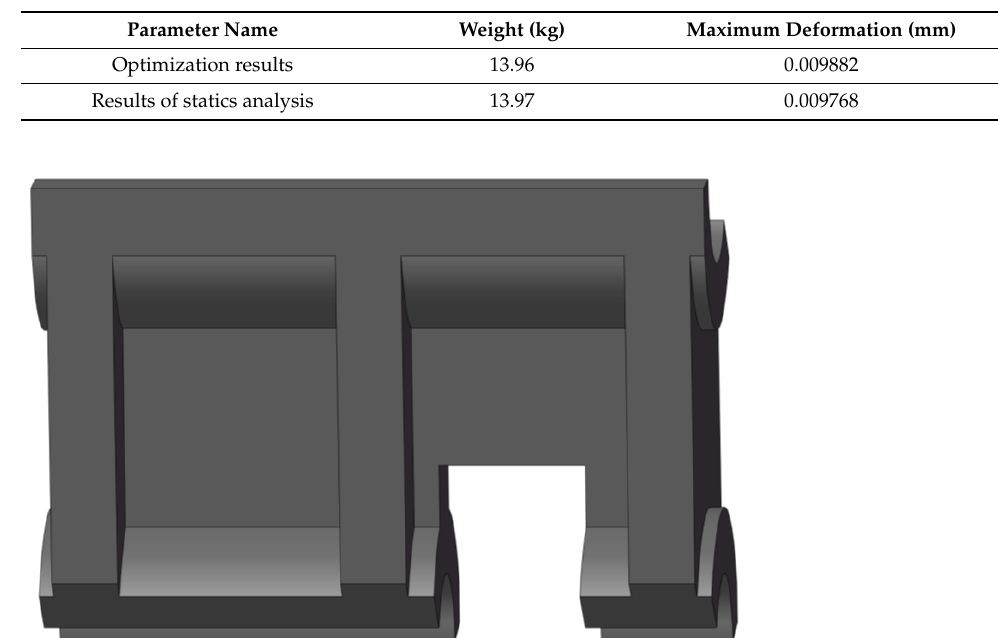
Figure 29. Grid division.